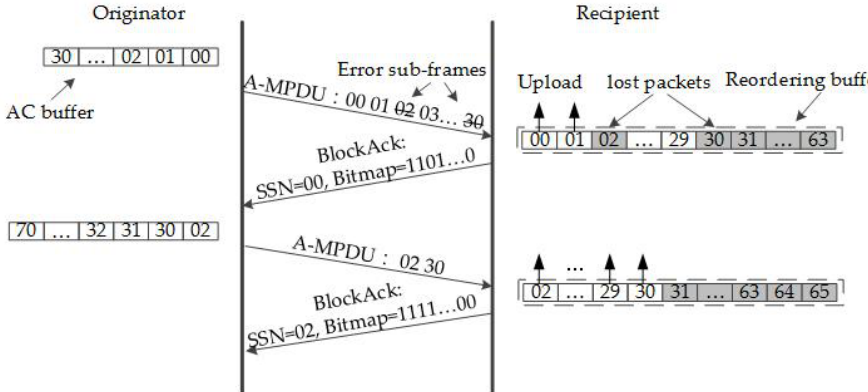
Figure 3. An example of the A-MPDU transmission using the aggregation selective repeat automatic repeat request (ASR-ARQ) scheme where W = 64.